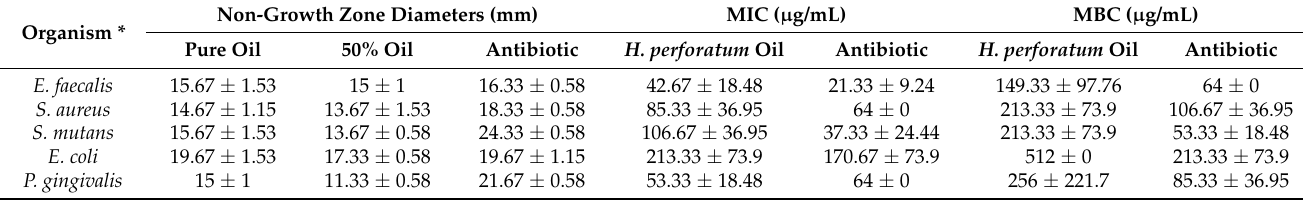
Table 1. The median non-growth zone diameters, MICs, and MBCs for the studied bacteria. Organism